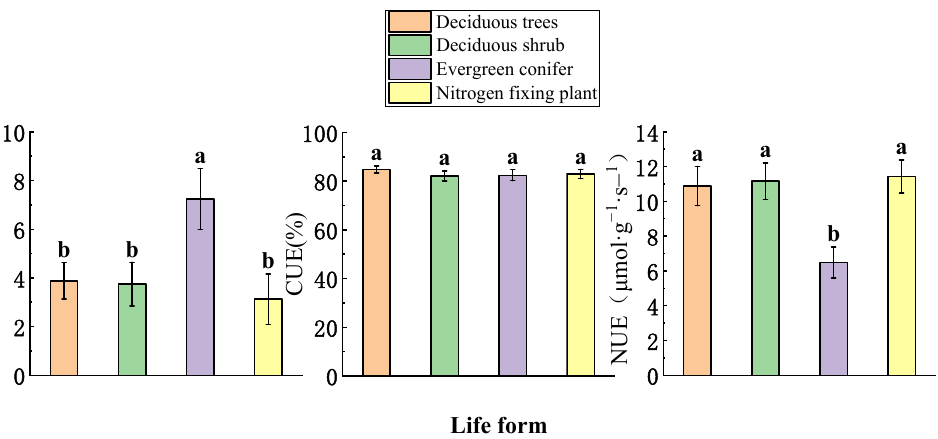
Figure 3. Comparison of mean value of water use efficiency (WUE), nitrogen use efficiency (NUE), and carbon use efficiency (CUE) between life forms (mean ± SE). Different small letters indicate significant difference between life forms for the same resource utilization efficiency ( p < 0.05).